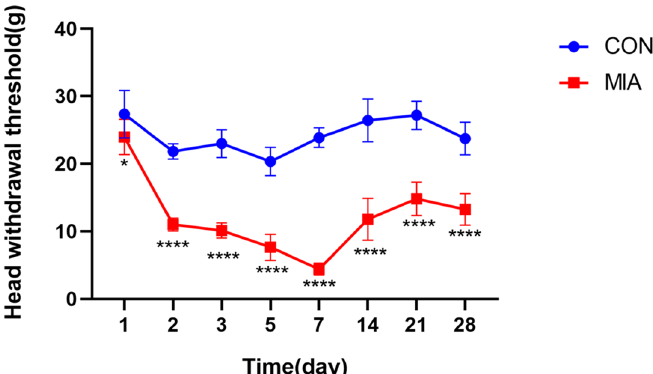
Figure 3. The head withdrawal threshold was tested. CON control group (n = 5). MIA: TMJ OA model group (n = 5). * P < 0.05; **** P <